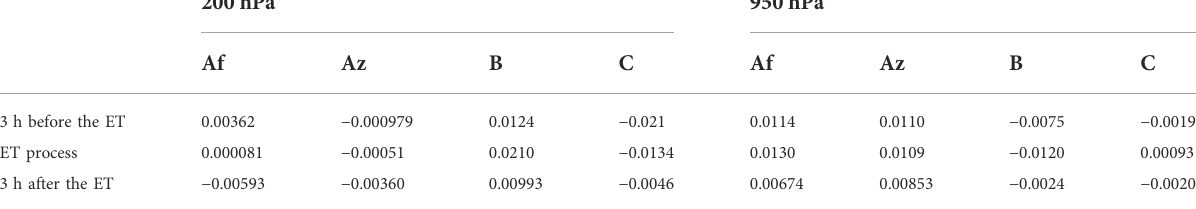
TABLE 1 Af, Az, B, and C at 200 hPa and 950 hPa (unit: Wm − 2